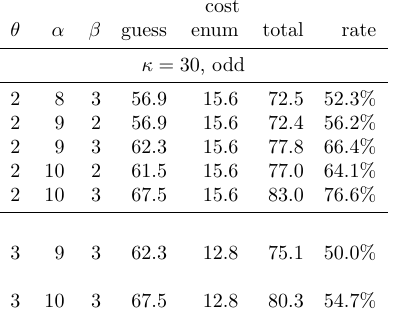
Table 15: Experimental results for New Hope parameters and κ = 30. For details see Table